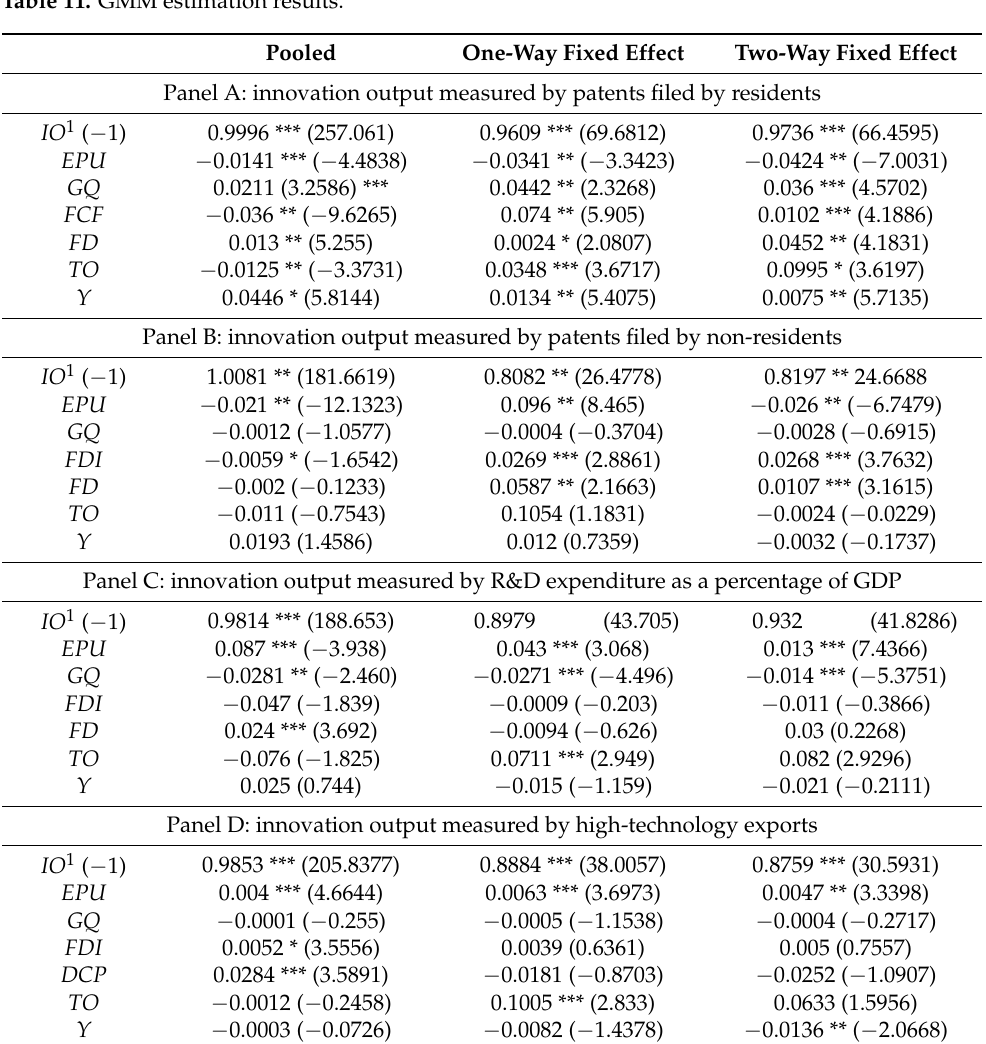
Table 11. GMM estimation